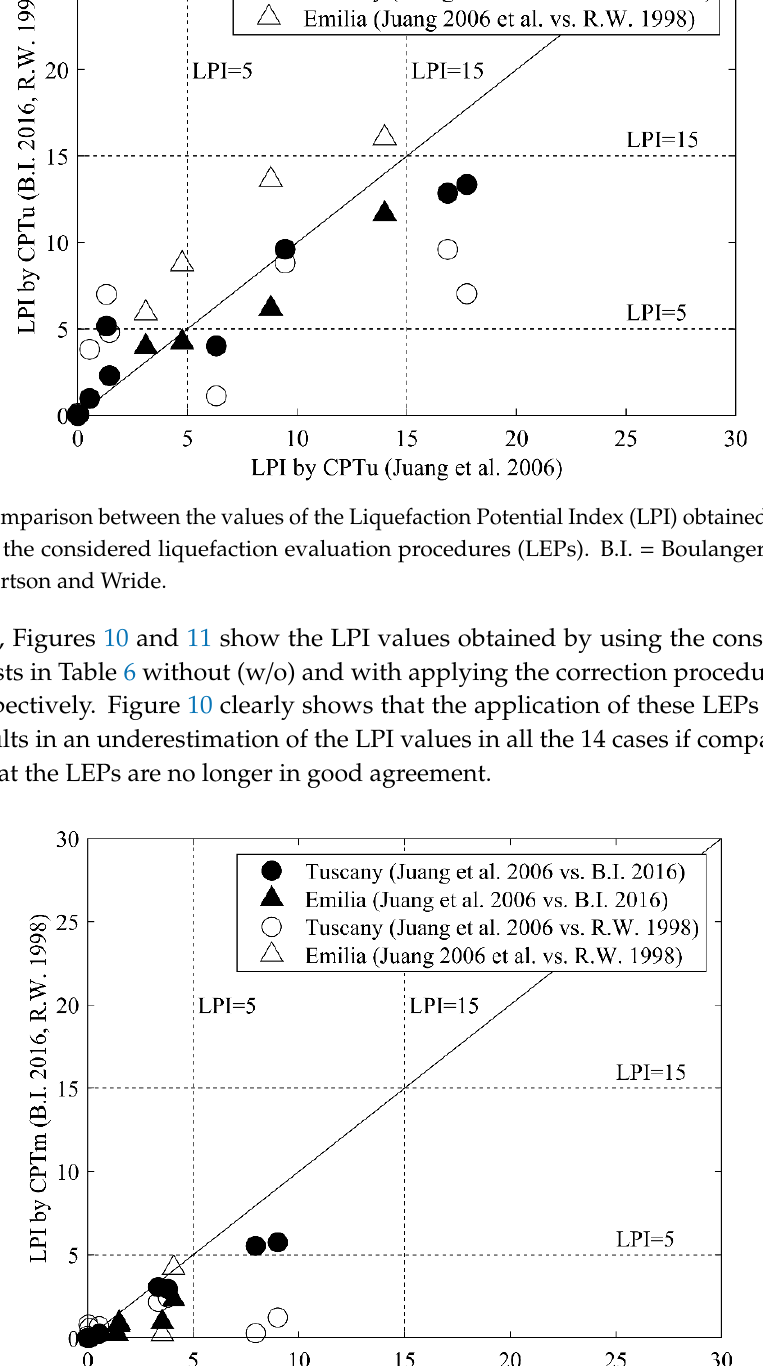
Figure 10. Comparison between the values of the LPI obtained with uncorrected CPTm data by using all the considered LEPs. B.I. = Boulanger and Idriss; R.W. = Robertson and Wride.